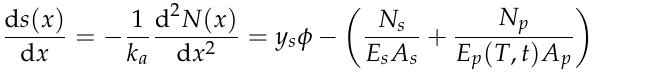
Figure 7. Comparison between numerical results and calculation results.